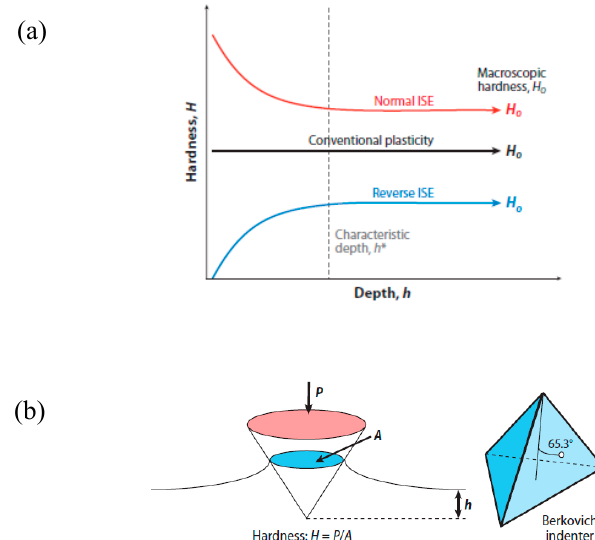
Figure 21. Indentation size effect (ISE) ( a ) for geometrically self-similar indenters such as a conical or pyramidal tip ( b ) [46]. Reproduced with permission from George M. Pharr et al., Proceedings